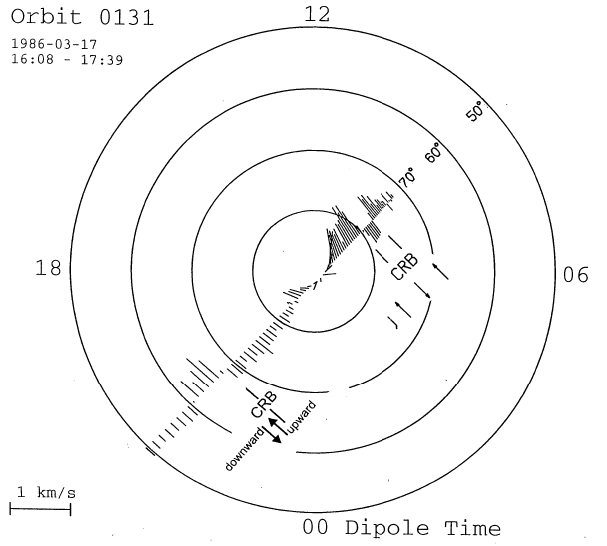
Fig. 8. Viking convection velocity mapped to the ionosphere in the corotating frame, based on the spin plane component of the elec- tric field for the pass shown in Figure 1. Averaging interval is 60 seconds. The convection reversal boundaries (CRB) and FAC direc- tions are marked.